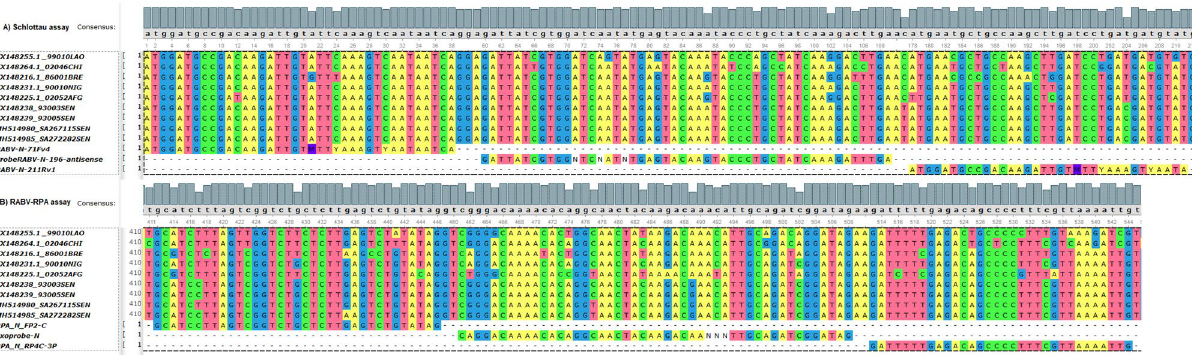
Figure 2. In silico analysis of ( A ) the Schlottau assay and ( B ) the RABV-RPA assay again sequences of differences rabies virus isolates from Laos (LAO), China (CHIN), Brazil (BRE), Niger (NIG), Afghanistan (AFG) and Senegal (SEN), respectively. The alignment was performed using the MAFFT algorithm implemented in the Unipro UGENE software 50 . The in silico analysis revealed signature erosion in the